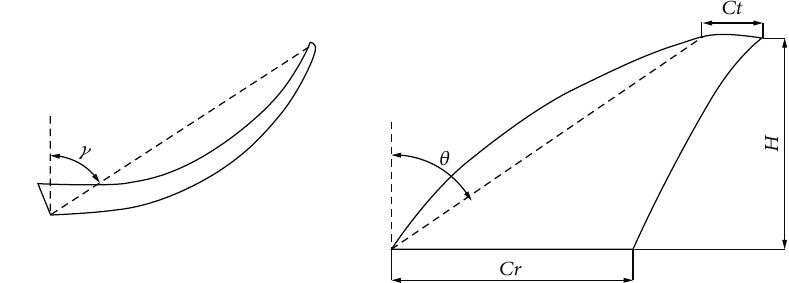
Figure 17: The geometric parameters of blended